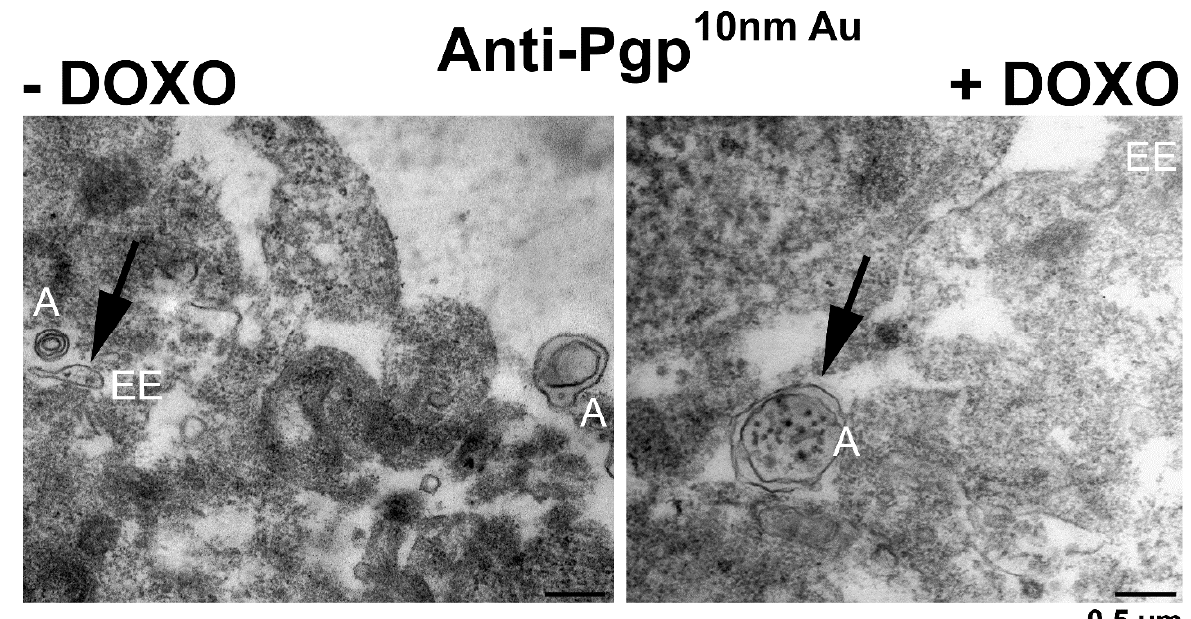
Figure 10. Ultrastructure of the localization of Pgp in immortalized hCMEC/D3- MDR1 -EGFP cells, in which Pgp-EGFP expression was induced by 1 µ g/mL doxycycline. In the left section, cells were sham-exposed, whereas in the right section, cells were exposed for 30 min to the Pgp substrate doxorubicin (DOXO; 10 µ M) followed by pre-embedding immunogold labeling. In the sham-exposed cells with small autophagosomes (A), Pgp was predominantly recognized in the early endosomes (EE, arrow). Following doxorubicin exposure, Pgp was immunolocalized in large autophagosomes (A, arrow).